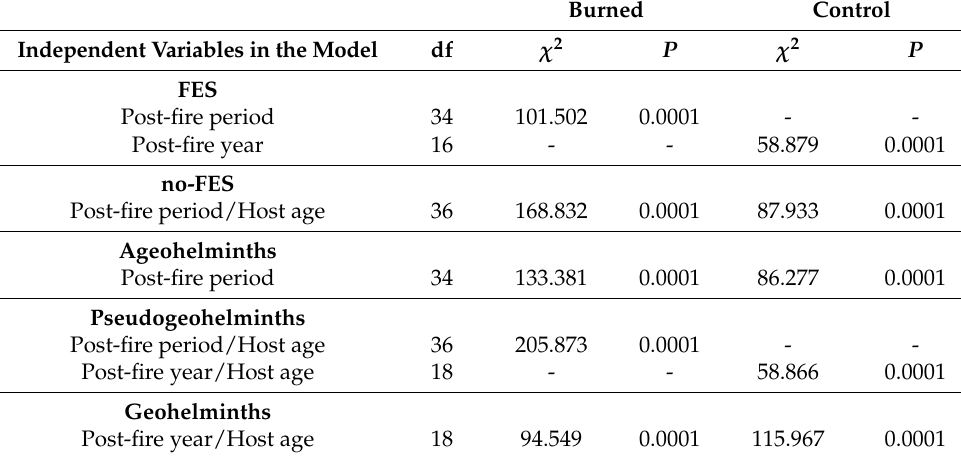
Table 10. Logistic regression models for prevalence of the five types of life cycles by year and period of capture, host age and host sex, in the burned and control areas, expressed by χ 2 values with associated probabilities ( P ) for the model created including independent variables. df = degree of